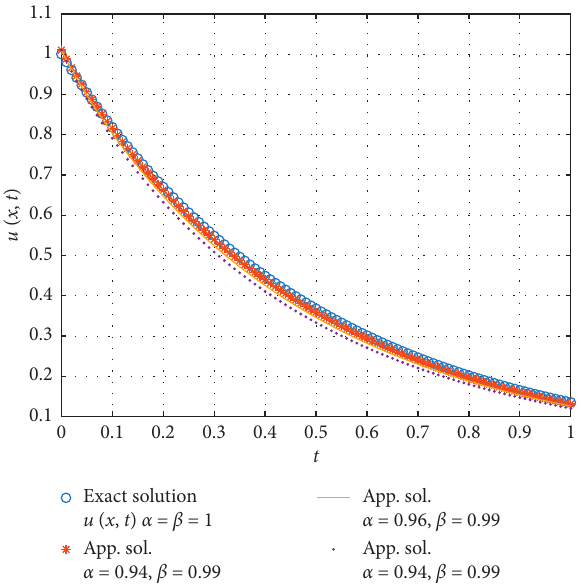
Figure 6: The exact and approximate solutions of u ( x,t ) , for Example 5, when we take different values of fractional order α and β � 0 .